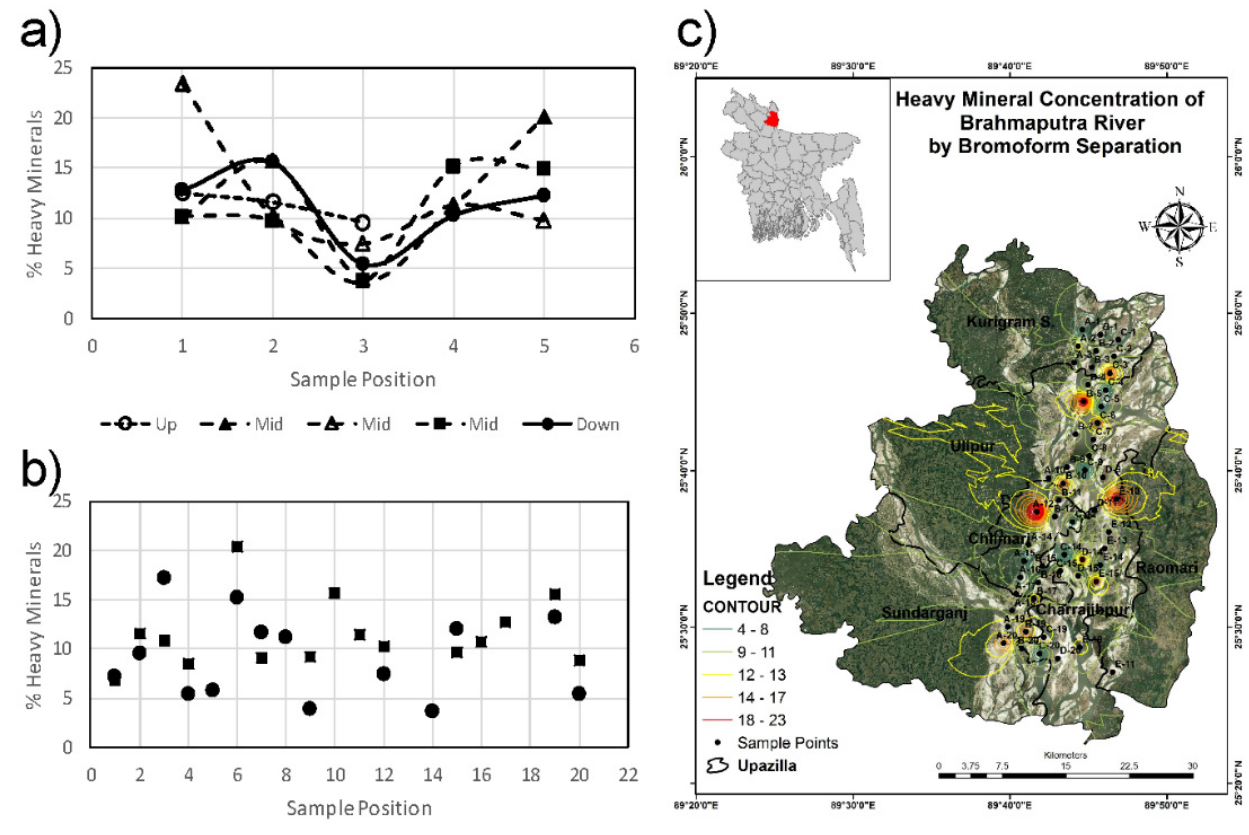
Figure 3. Plots showing the distribution of THM in Brahmaputra River samples according to location. ( a ) THM distribution across the river channel from west (position 1) to east (position 5) plotted according to location. Points represent data from cross-sections taken upstream, midstream and downstream. Position 1 is situated on the west bank, positions 2, 3 and 4 are mid-channel and position 5 is the east bank. ( b ) Distribution of THM’s from north (upstream—LHS) to south (downstream—RHS). Samples are from borehole locations along the B and C transects, i.e., mid-channel locations, ( c ) a map showing the amount of THMs measured at each sample location.